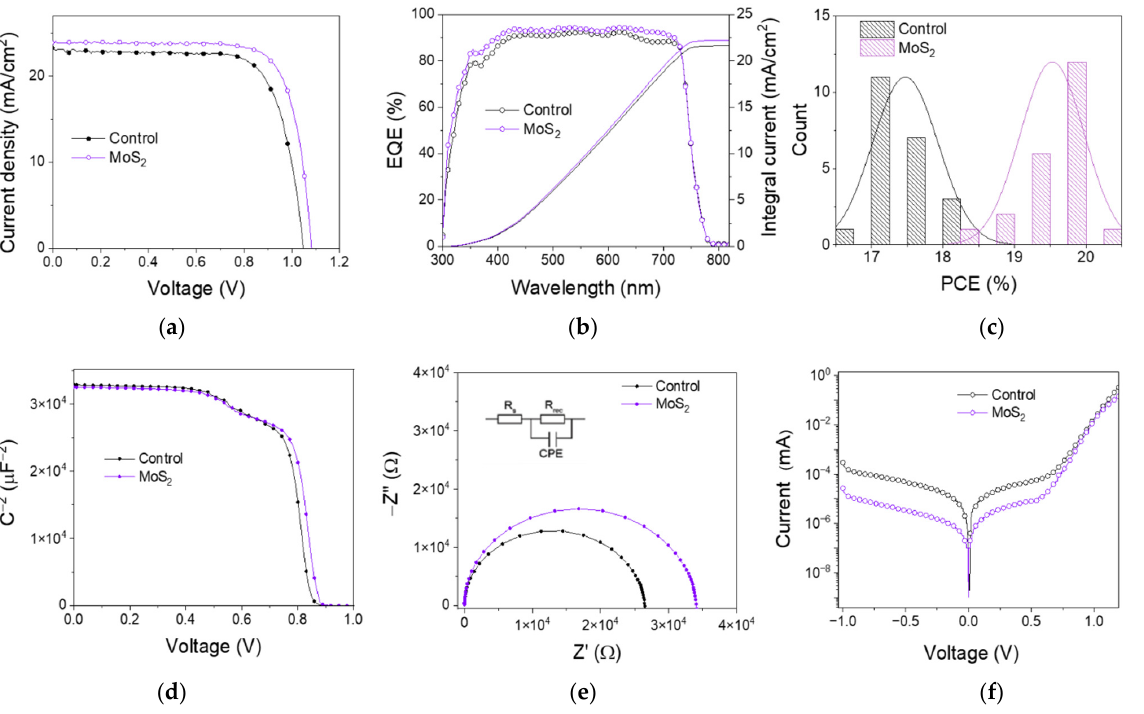
Figure 7. ( a ) J–V curves of control device and devices treated with MoS 2 QDs at different concentrations. ( b ) IPCE measurement of control device and device treated with MoS 2 QDs. ( c ) Measurement for PCE of devices with and without MoS 2 , where 22 cells were collected for each batch. ( d ) Capacitance–voltage curves of control device and device treated with MoS 2 QDs. ( e ) Nyquist plots of con-